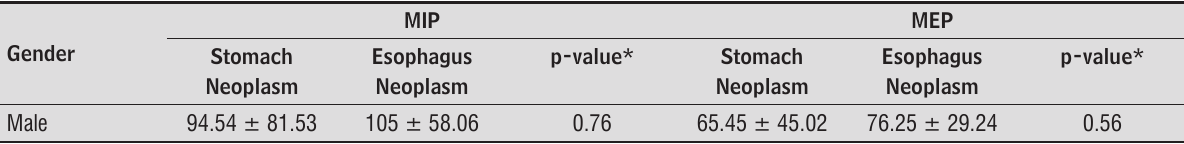
Table 3 - Comparison of maximum respiratory pressures found between male patients with stomach and esophageal neo-